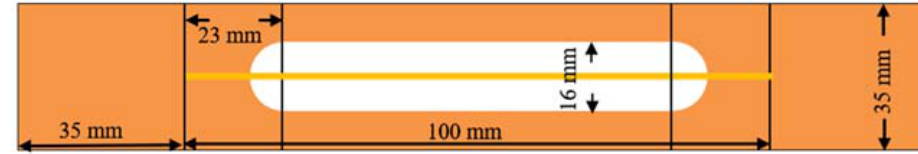
Figure 4. Schematic diagram of fiber monofilament tensile processing and molding sample.